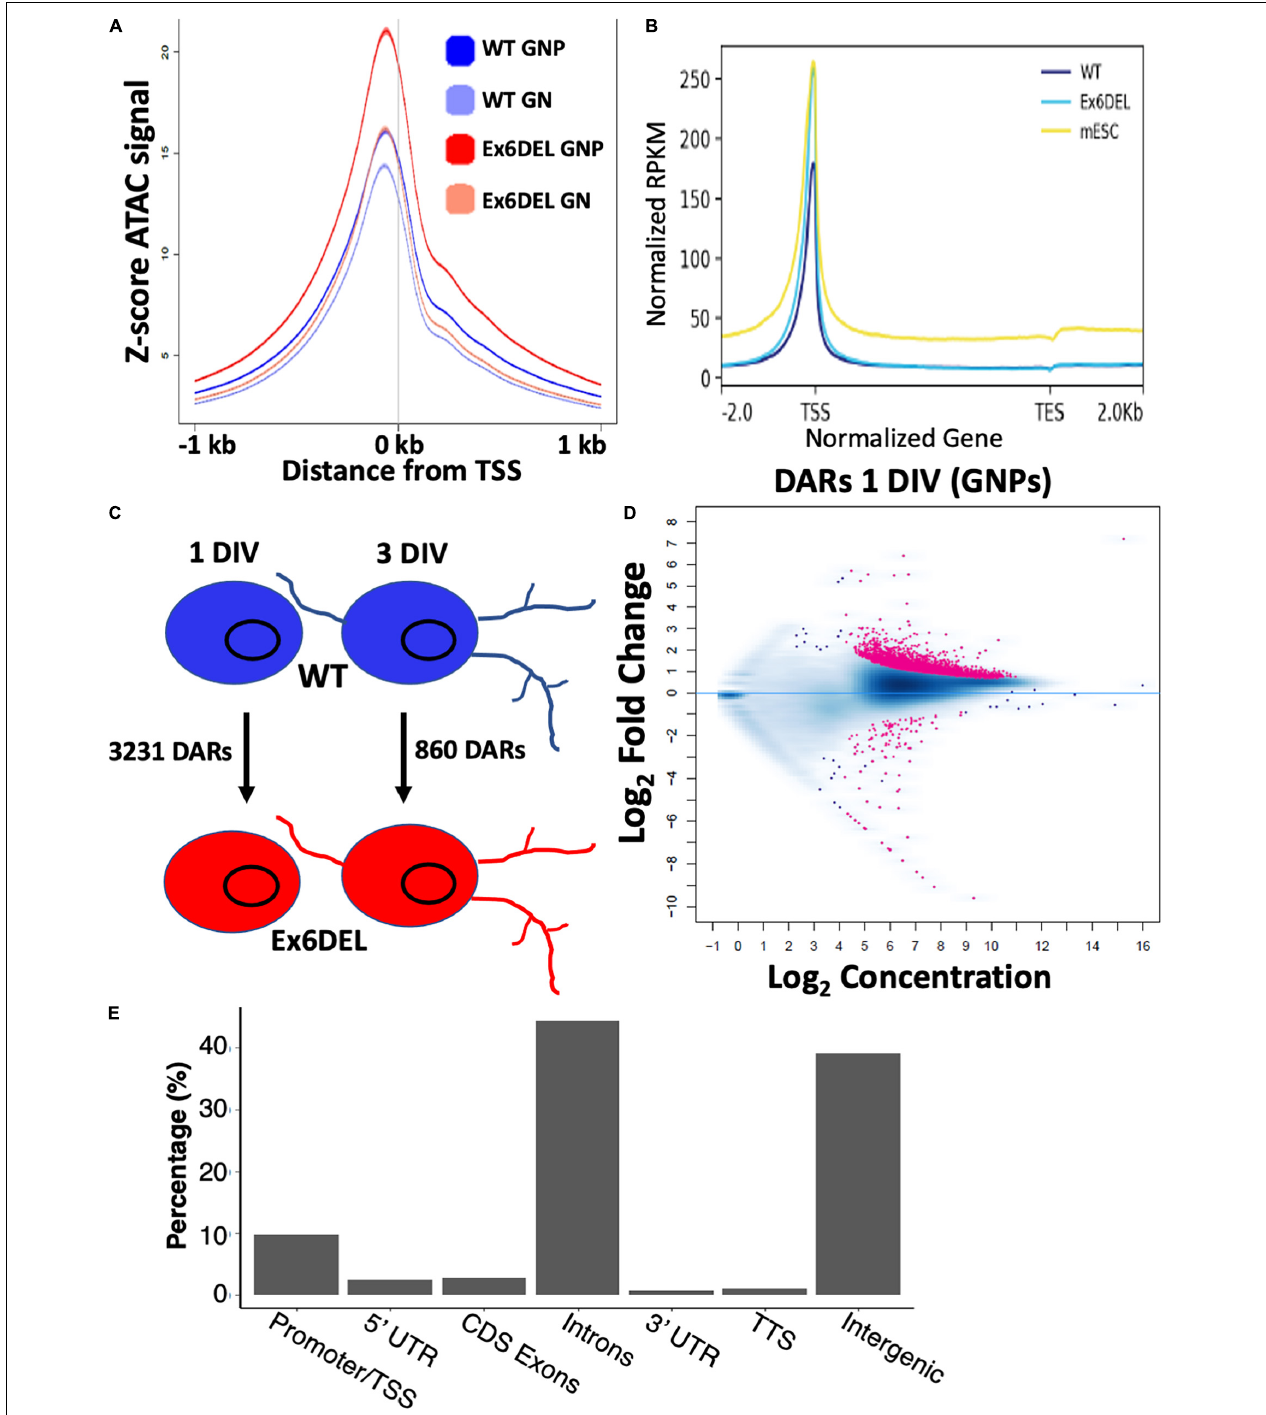
FIGURE 4 | ATACseq analysis of WT and Ex6DEL cultures. (A) Compilation of all ATACseq peaks showing enrichment at the TSS under all culture conditions. Mutant cultures at 1 DIV (Ex6DEL GNP) showed the greatest enrichment of peaks at the TSS, followed by Ex6DEL GN (3 DIV), WT GNPs and WT GNs. (B) Peaks aligned to a normalized genes showed that Ex6DEL chromatin (light blue) was more accessible than WT chromatin (dark blue) and more similar to the profile of ESCs (yellow). TSS, transcriptional start site; TES, transcriptional end site. (C) Schematic diagram showing the numbers of differentially accessible regions (DARs) between WT and Ex6DEL samples at 1 and 3 days in culture. (D) MA plot of the 3231 differentially accessible regions. Pink dots represent significant changes in accessibility, with dots above the line representing increased accessibility and below the line decreased accessible regions. (E) Plot showing the frequency of DARs at different genomic positions. Promoter/TSS, − 1KB to +100 bp; 5 (cid:48) UTR, > 100 bp from TSS; TTS, transcriptional termination sites.